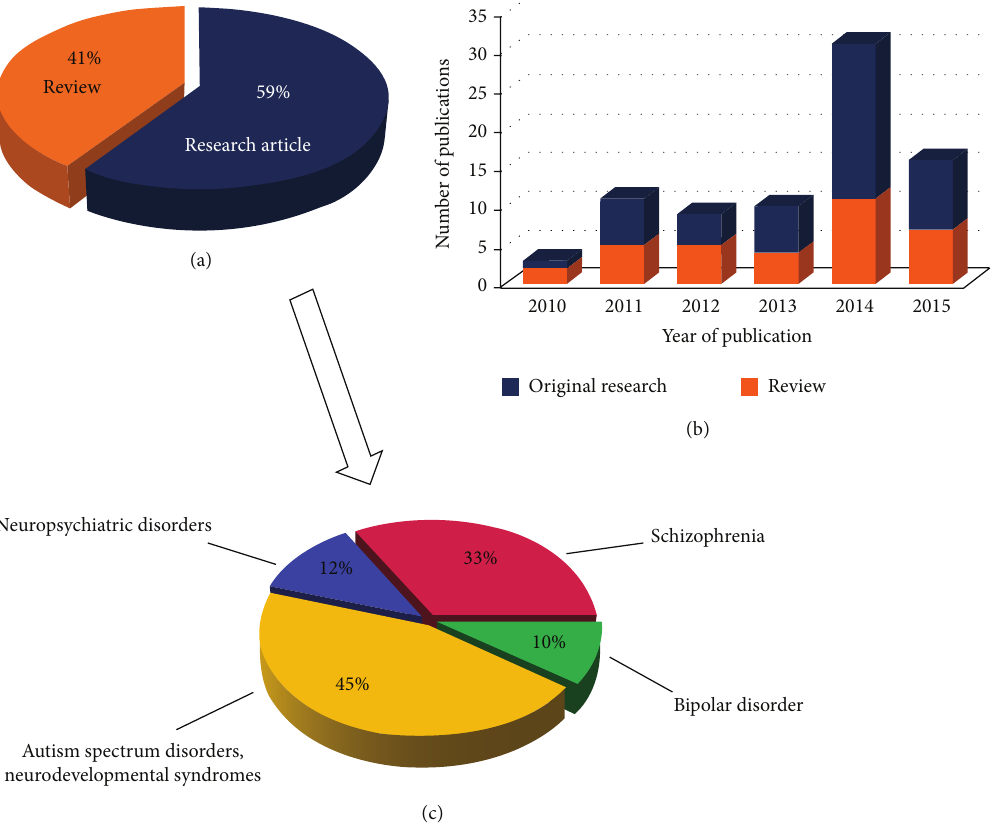
Figure 2: (a), (b), and (c) Characteristics of current literature dealing with induced pluripotent/neural cell lines in psychiatric research. (c) Represents the research articles only. Publications were reviewed until June,